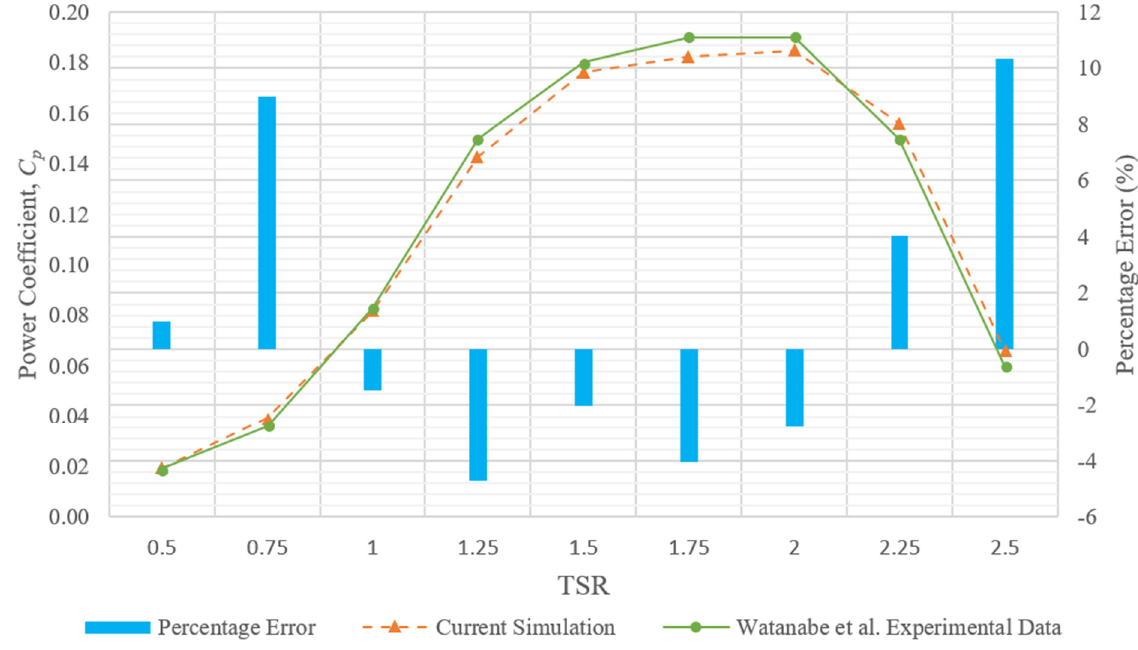
Figure 5. Model validation with experimental data from Watanabe et al. [25].